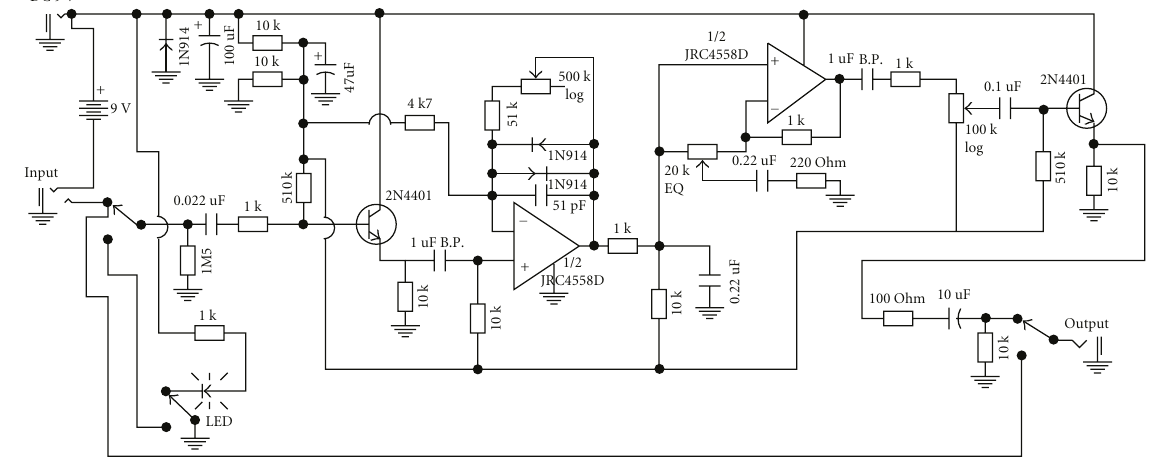
Figure 4: Circuit diagram of the home-made overdrive e ff ect